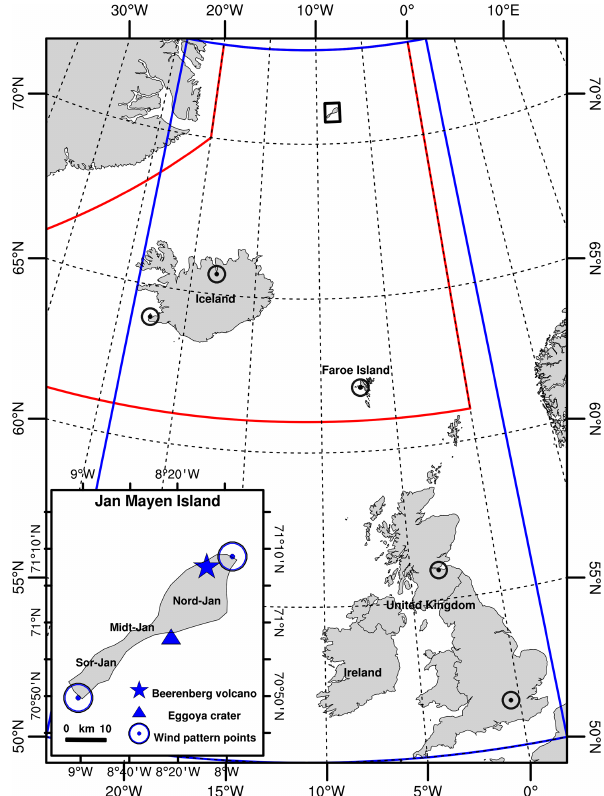
Figure 1. JM location and computational domain for the JM PVHA including Iceland, Ireland, and the United Kingdom (blue box). The red contour shows the FIR (flight information region) for which the Icelandic Meteorological Office is responsible (for visualiza- tion purposes only). The blue star and triangle on the zoomed-in map indicate the location of the Beerenberg volcano and Eggøya crater (1732 Surtseyan eruption) respectively. The two blue circles show the two hypothetical vent locations in the wind profile anal- ysis. Black circles correspond to Keflavik and Akureyri (Iceland), Vágar (Faroe Islands), Edinburgh (Scotland), and Heathrow (Lon- don, UK) airports. Nord-Jan, Midt-Jan, and Sør-Jan correspond to the three areas into which JM is classically